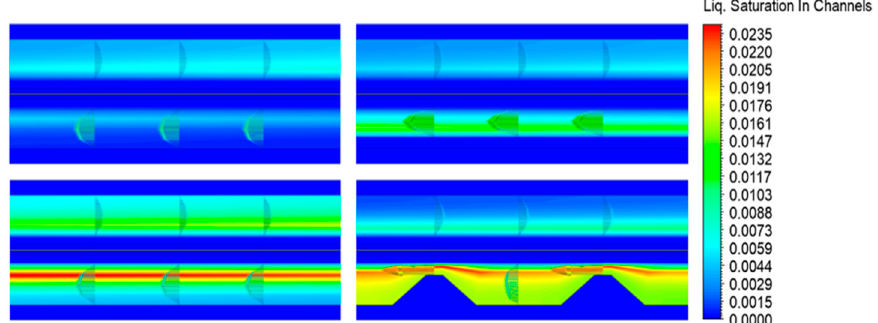
Figure 7. Liquid saturation in channels contours: conventional rectangular channels ( above left ); biporous cathode channel ( above right ); porous cathode channel ( below left ); porous and baffled cathode channel ( below right ) at operating current density of 4.0 A·cm − 2 .